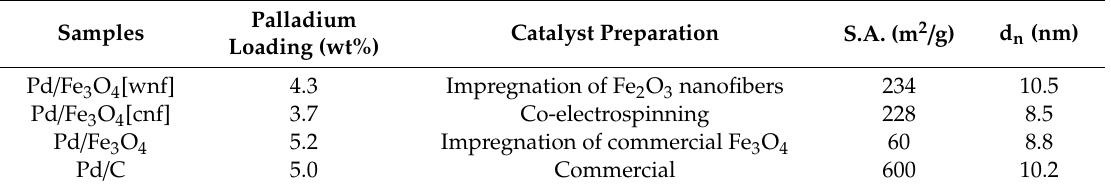
Table 1. Main characteristics of the supported palladium catalysts investigated (S.A.: surface area; d n : mean particle size from TEM).